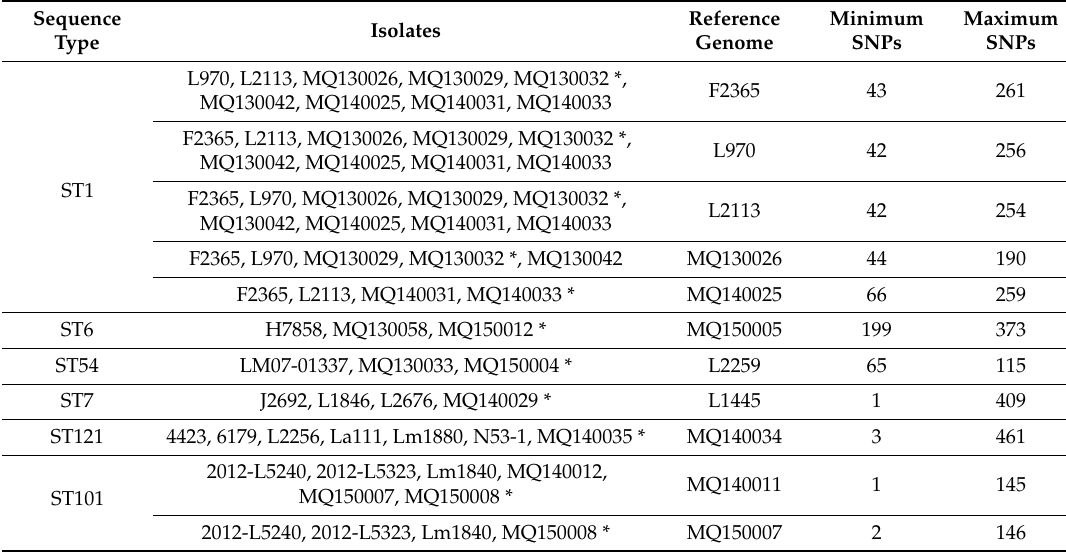
Table 2. Relatedness of strains as determined by fine single nucleotide polymorphism (SNP) analysis with appropriate reference